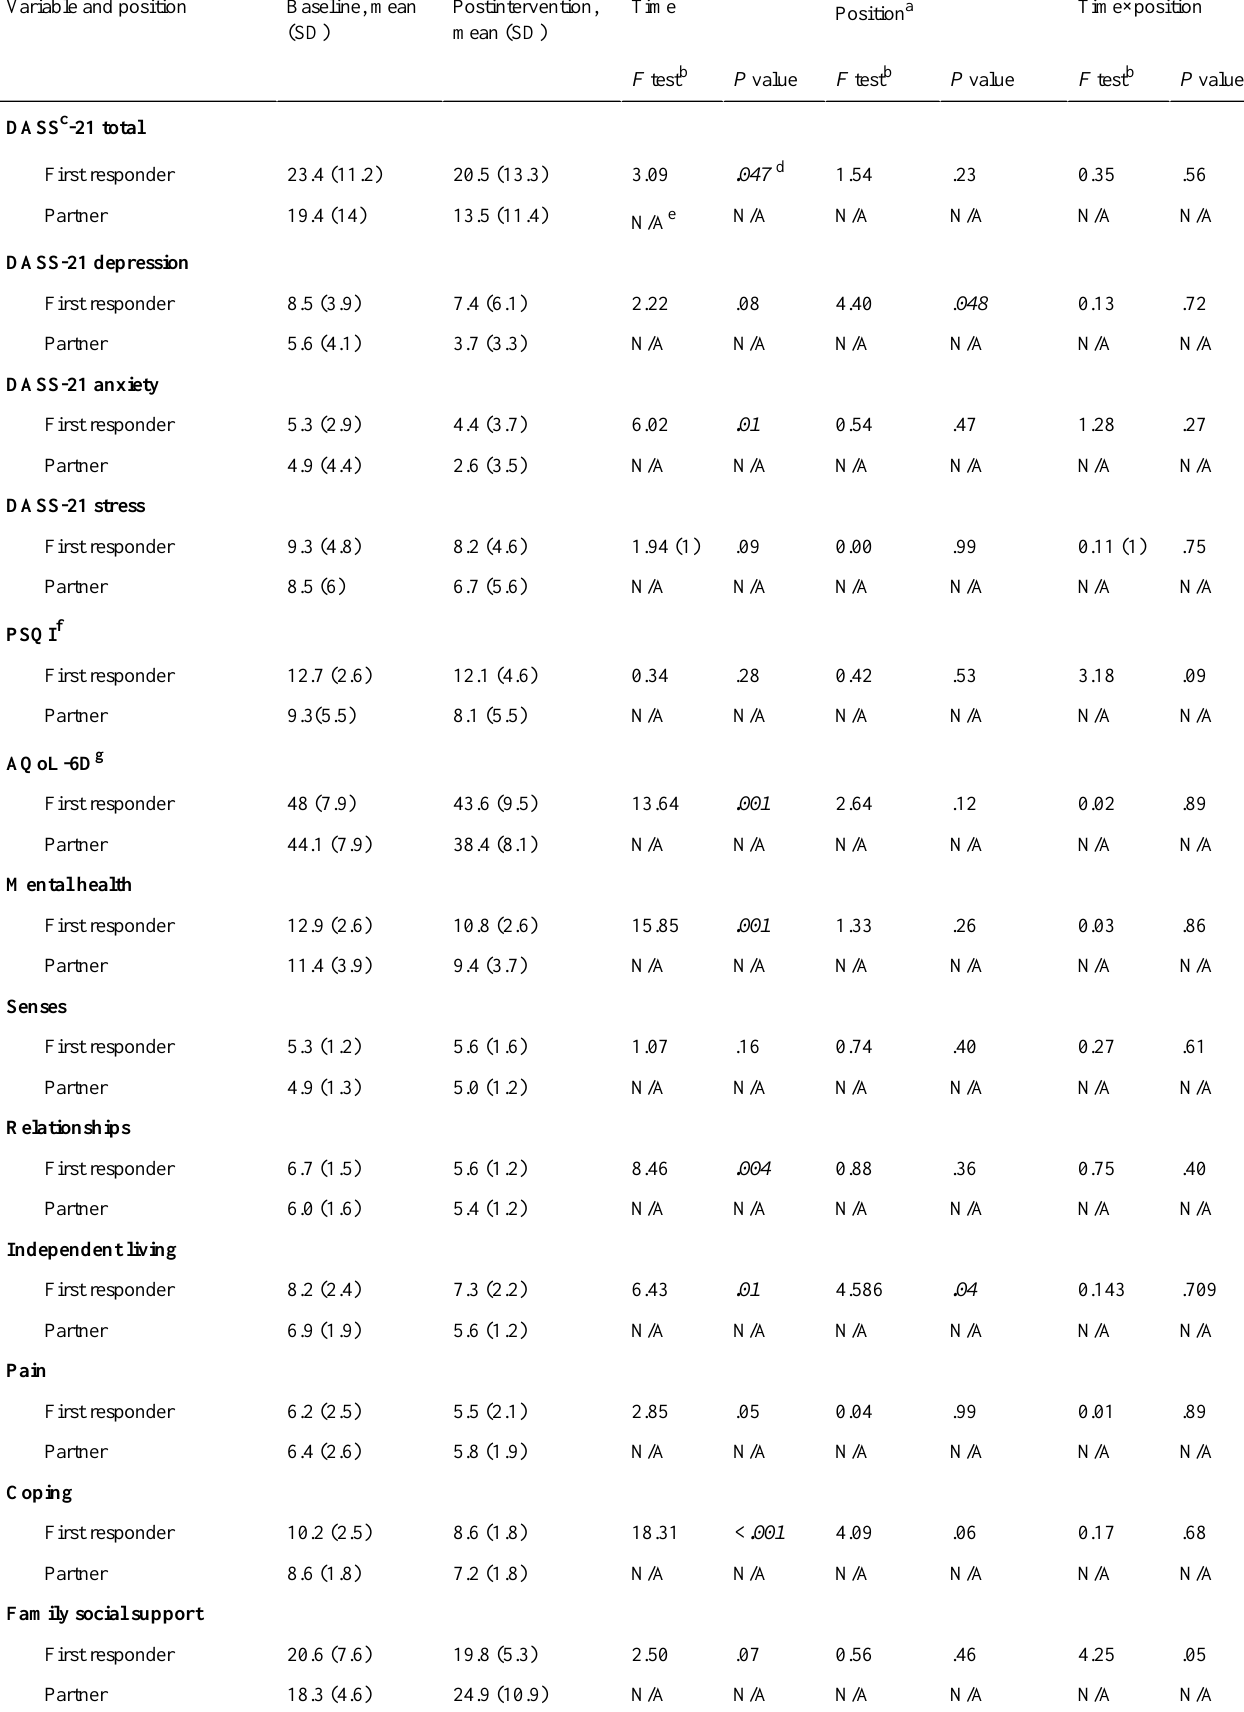
Time×positionPosition a TimePostintervention,